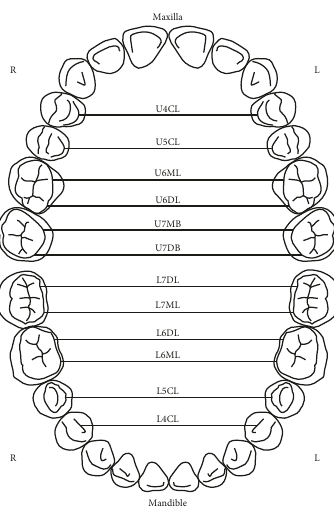
Figure 1: Illustration of the maxillary and mandibular arches’ widths as described by Ling and Wong [9]. U3CB: cusp tip of tooth 13 and tooth 23; U4CB: buccal cusp of tooth 14 and tooth 24; U5CB: buccal cusp of tooth 15 and tooth 25; U6MB: mesial buccal cusp of tooth 16 and tooth 26; U6CB: buccal groove at the buccal and occlusal surface interface of tooth 16 and tooth 26; U6DB: distal buccal cusp of tooth 16 and tooth 26; U7MB: mesial buccal cusp of tooth 17 and tooth 27; U7CB: buccal groove at the buccal and occlusal surface interface of tooth 17 and tooth 27; U7DB: distal buccal cusp of tooth 17 and tooth 27; L7DB: distal buccal cusp of tooth 37 and tooth 47; L7CB: buccal groove at the buccal and occlusal surface interface of tooth 37 and tooth 47; L7MB: mesial buccal cusp of tooth 37 and tooth 47; L6DB: distal buccal cusp of tooth 36 and tooth 46; L6CB: buccal groove at the buccal and occlusal surface interface of tooth 36 and tooth 46; L6MB: mesial buccal cusp of tooth 36 and tooth 46; L5CB: buccal cusp of tooth 35 and tooth 45; L4CB: buccal cusp of tooth 34 and tooth 44; L3CB: cusp tip of tooth 33 and tooth 43.